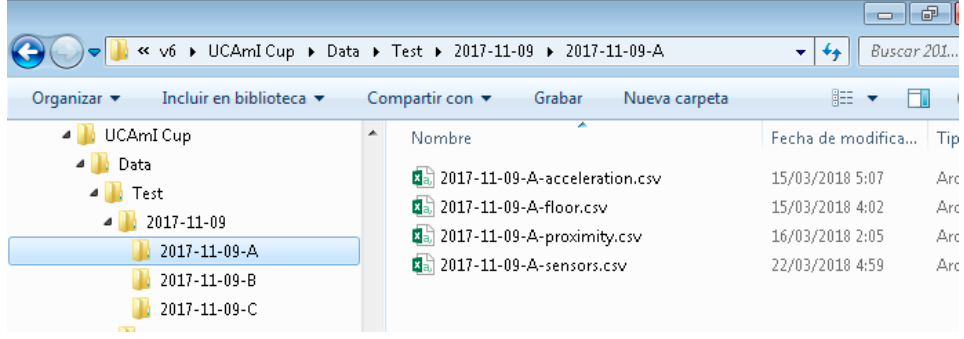
Figure 6. Files in the data folder called “2017-11-09-A” in the test set.